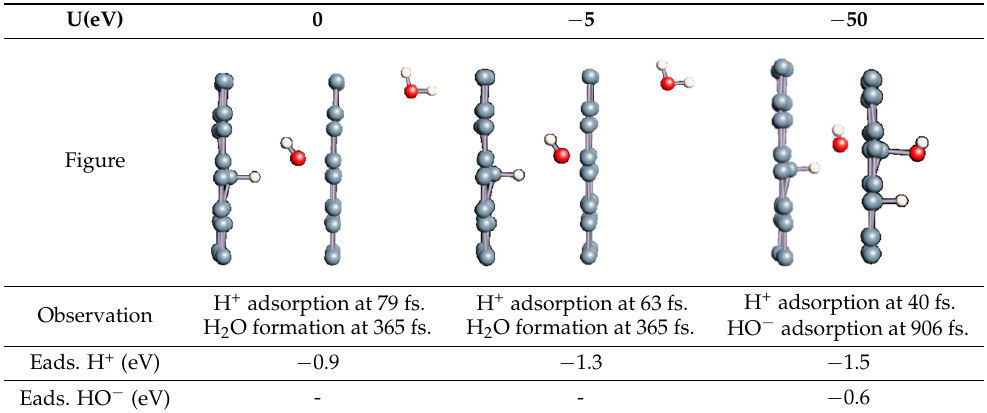
Table 1. Adsorption states and energies of dissociated water molecules on the graphene monolayer.